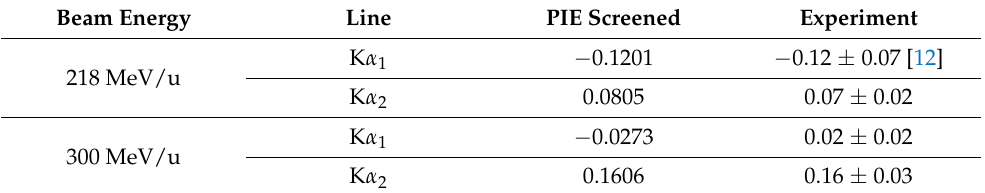
Table 3. Experimental values in comparison with theoretical predictions for the effective anisotropy parameters for the K α 1 and K α 2 lines of helium-like uranium ions produced by K → L excitation in collisions with argon atoms. PIE calculations were performed for the screened potential.